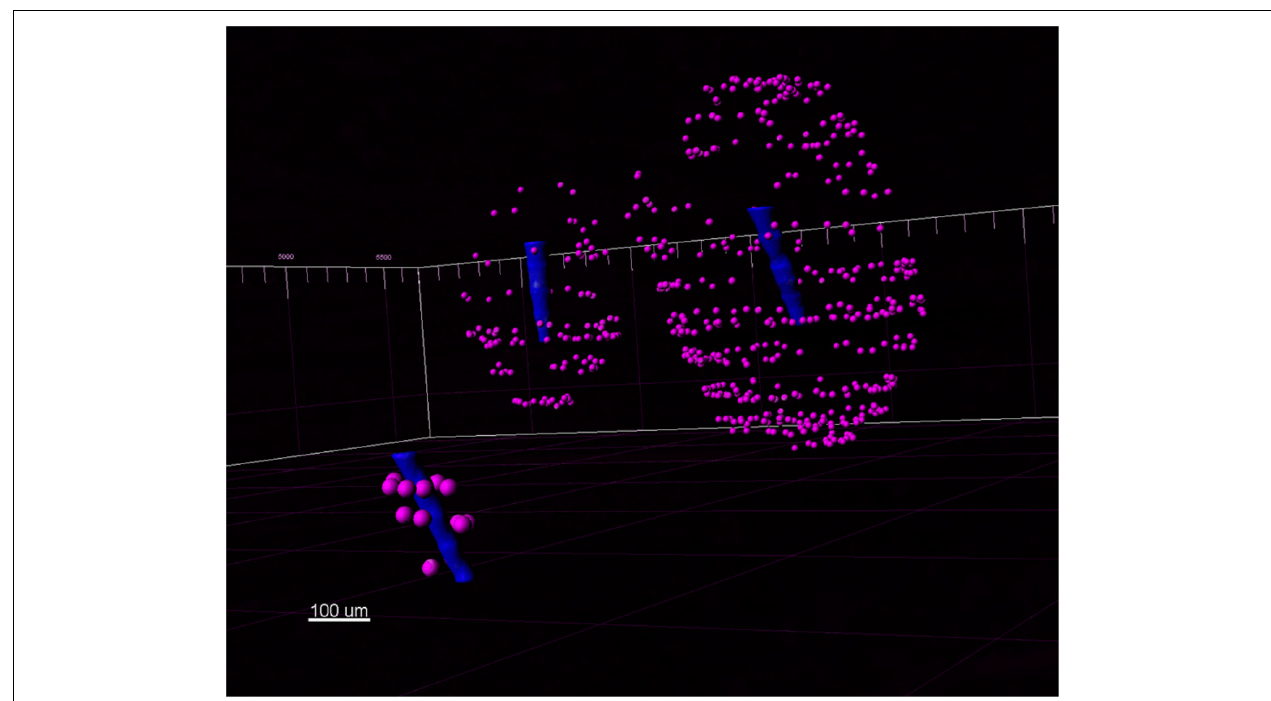
FIGURE 8 | A view of three Blackrock shank tips (blue) with neurons (magenta) detected in the 3D reconstructed volume.